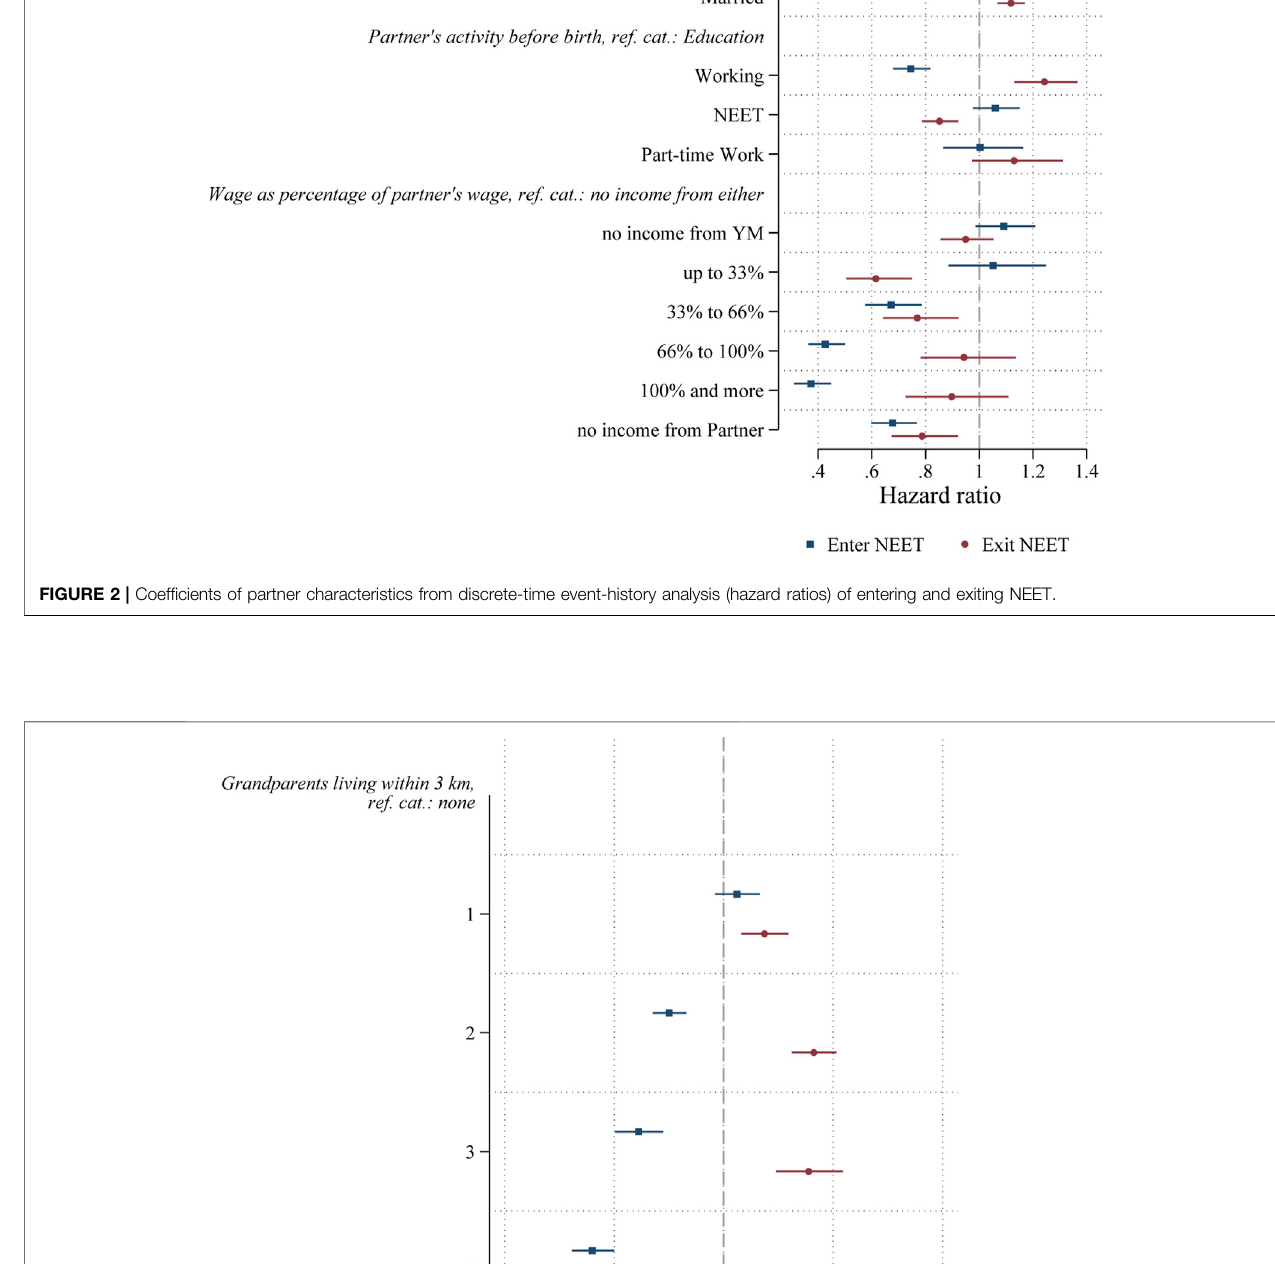
Frontiers in Sociology |